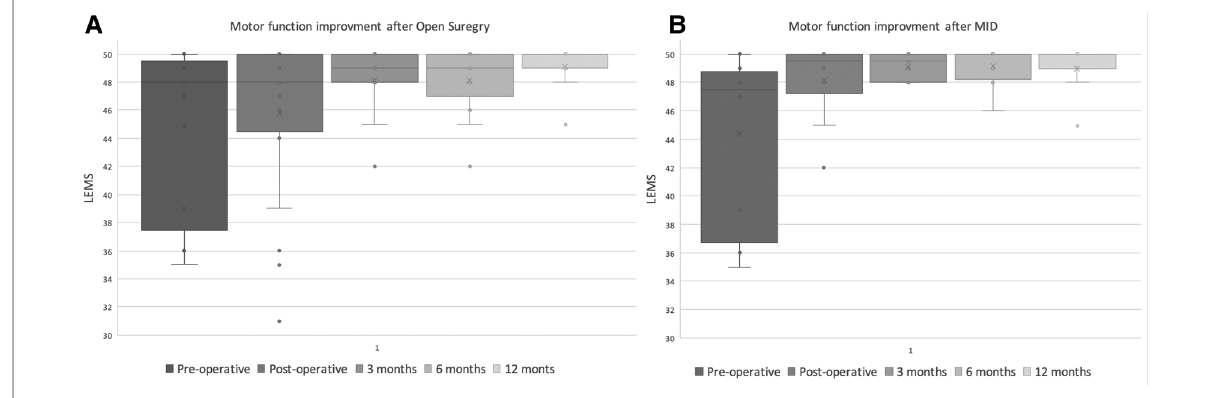
FIGURE 4 Distribution of reported lower extremity motor score (LEMS) of the MID ( A ) and open decompression ( B ) groups at preoperative, immediate postoperative, 3,6,12